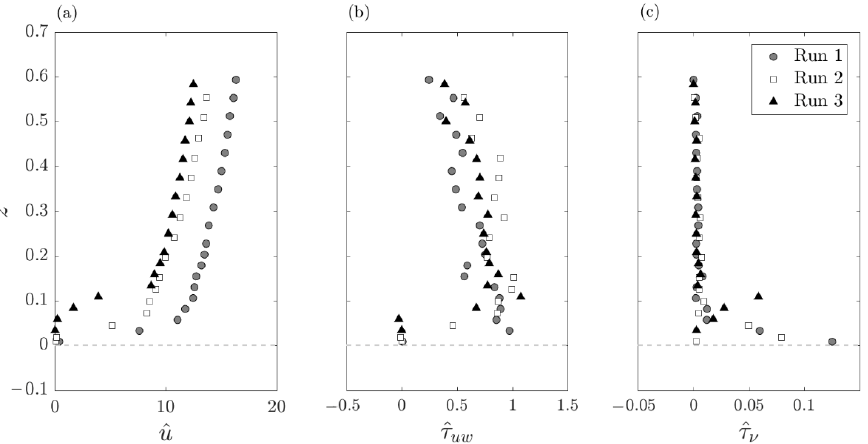
Figure 4. Vertical profiles of ( a ) dimensionless time-averaged velocity, ( b ) dimensionless Reynolds shear stress and ( c ) dimensionless viscous shear stress for the undisturbed flow condition (50 cm upstream to the vegetation array) in Run 1, Run 2 and Run 3.